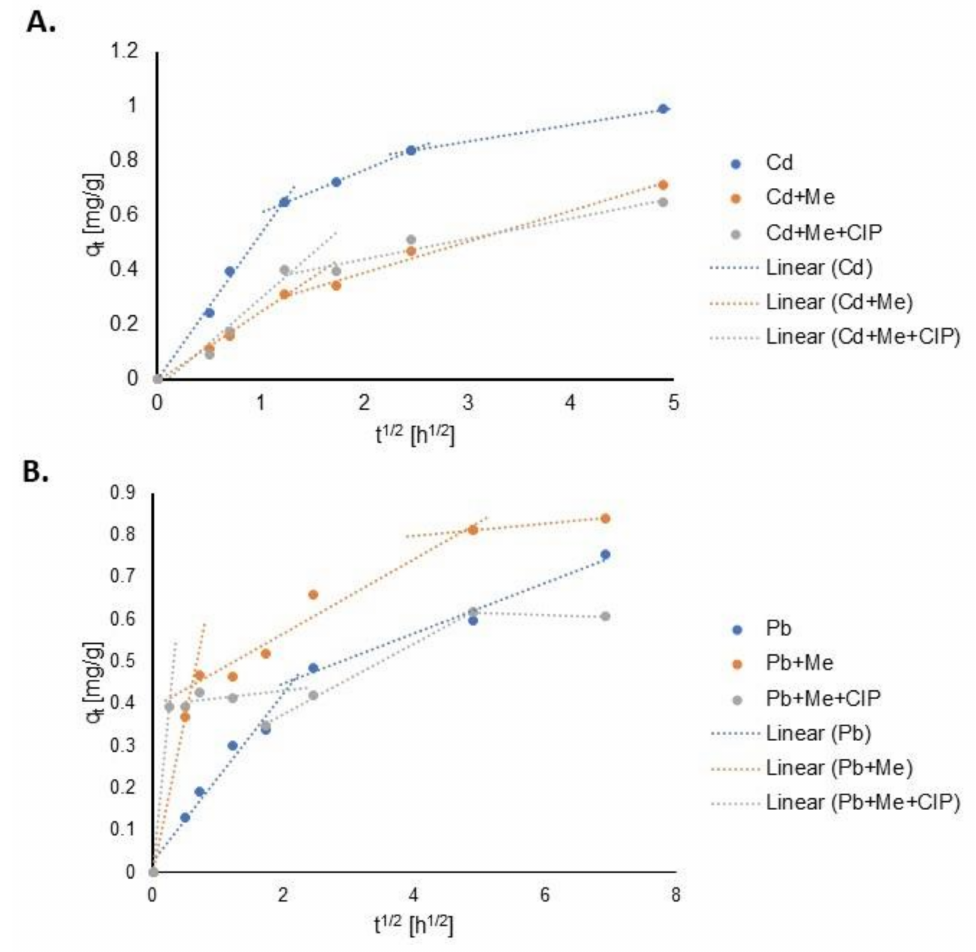
Figure 6. Kinetic curves of intraparticle diffusion model for Cd ( A ) and Pb ( B ) onto